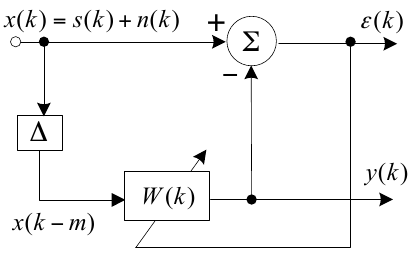
Figure 3. Block diagram of the adaptive line enhancer (ALE).